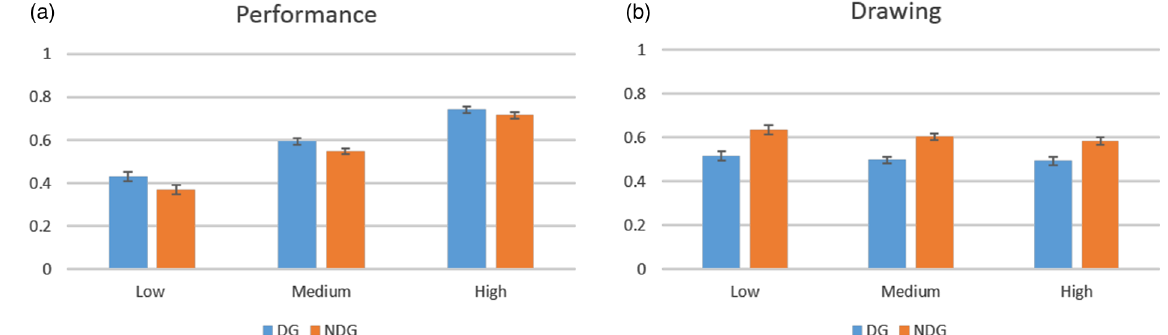
FIG. 6. The impact of DG and NDG condition on students with different skill backgrounds averaged over all 6 experiments. (a) The impact on performance as measured by first attempt correct rate. (b) The impact on drawing behavior.